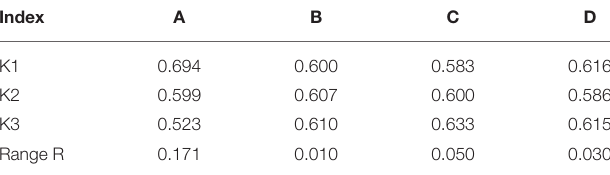
TABLE 4 | ANOR table of process parameter in four-stages SPIF.